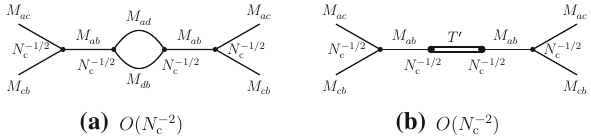
Fig. 12 Two-meson intermediate-state contributions to the three chan- nels at N c -leading order: direct channel I ( a , b ), direct channel II ( c ) and recombination channel ( d )